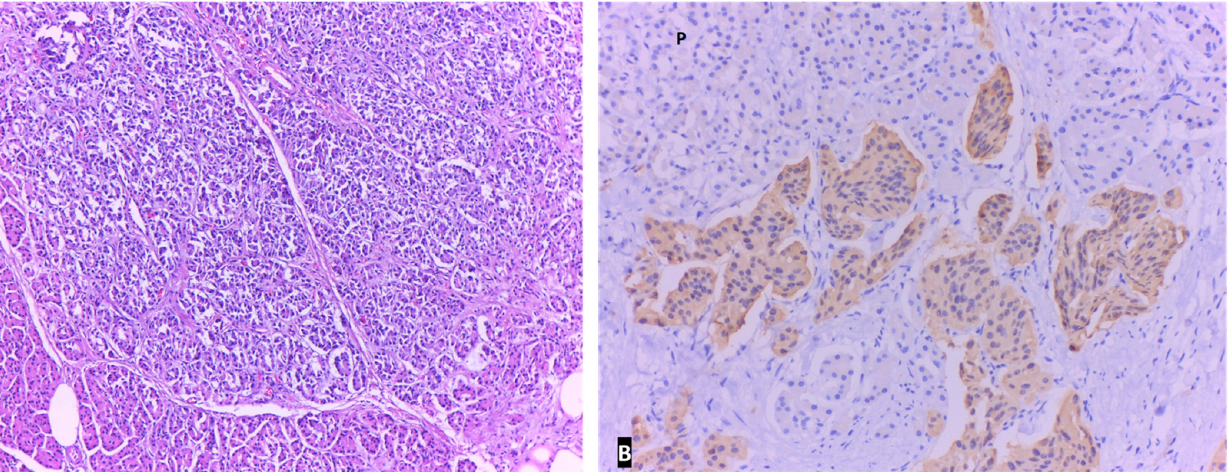
Figure 8. NEN infiltrating duodenal muscularis propria. Perineural infiltration is seen (*) in Hema ‐ toxylin and eosin stain, ×200.